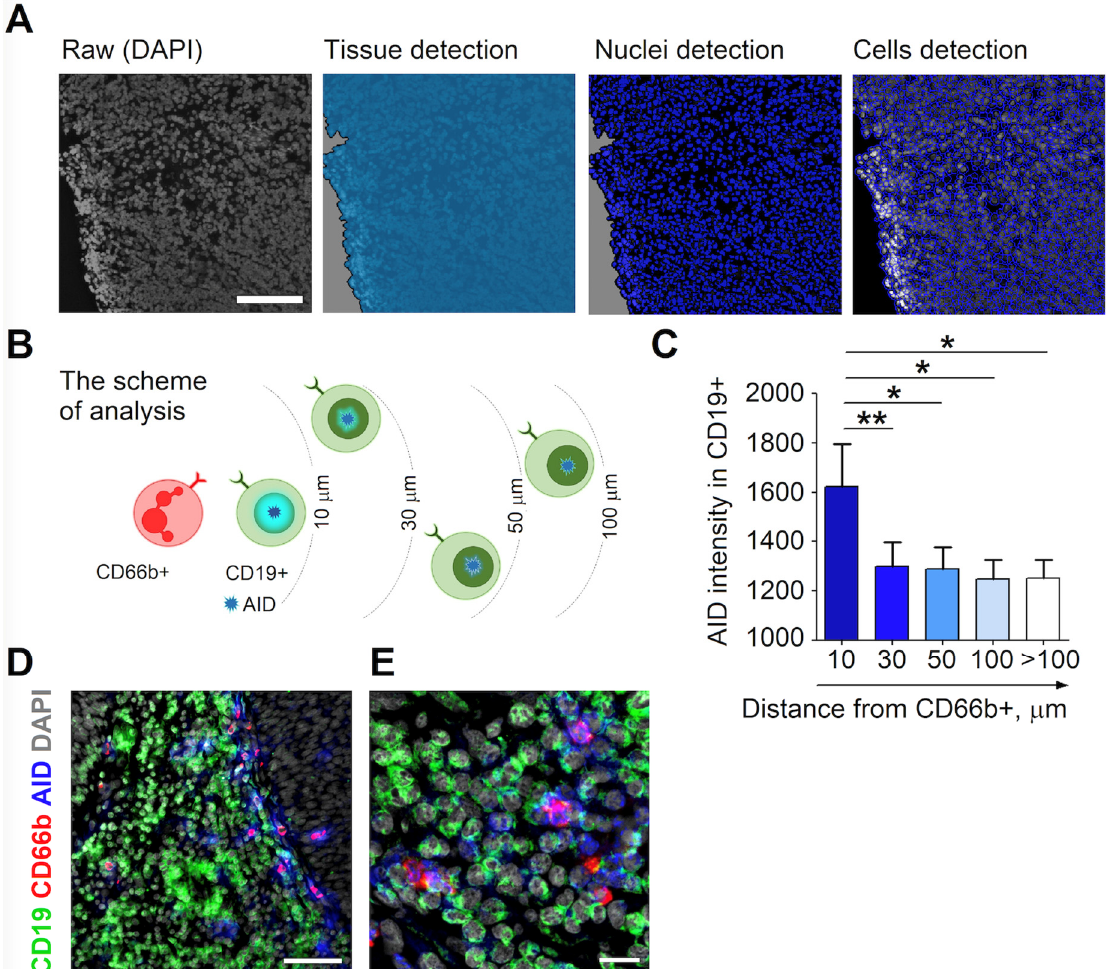
Figure 3. B cells in close proximity to N BH express significantly higher levels of AID in the RLN of HNC patients. RLNs ( n = 16) of HNC patients were frozen, cryosections stained, and the expression of AID was estimated in CD19 + cells. This was correlated with the distance from CD66b + neutrophils. Images (numbering 3–5 per individual LN) were evaluated. ( A ) Representative images of tissue detection (light blue filling), nucleus detection (dark blue filling) and cell detection (dark blue line) in RLNs with Tissue Studio software. Scale bar 50 µm. ( B ) Schematic diagram of the scientific approach and analysis of the data from Tissue Studio software ( C ) Increased AID intensity in B cells with neutrophil vicinity. Neutrophil distance by 10, 30, 50, 100 and >100 µm are shown. ( D , E ) Representative images of the immunofluorescence staining of LN tissues for neutrophils (red), B cells (green) AID (blue) and DAPI (gray). Scale bar, 100 µm ( D ) and 20 µm ( E ). For nonparametrically distributed samples, a Kruskal–Wallis ANOVA with the Bonferroni correction for multiple comparisons and a Wilcoxon test for dependent samples were used. Data are shown as individual values and mean. ** p < 0.01, * p < 0.05.